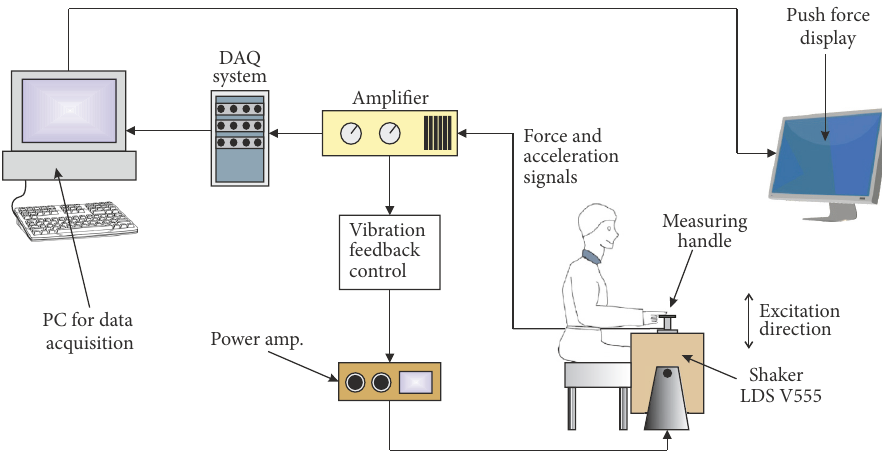
Figure 6: Experimental setup used in the study for the finger apparent-mass